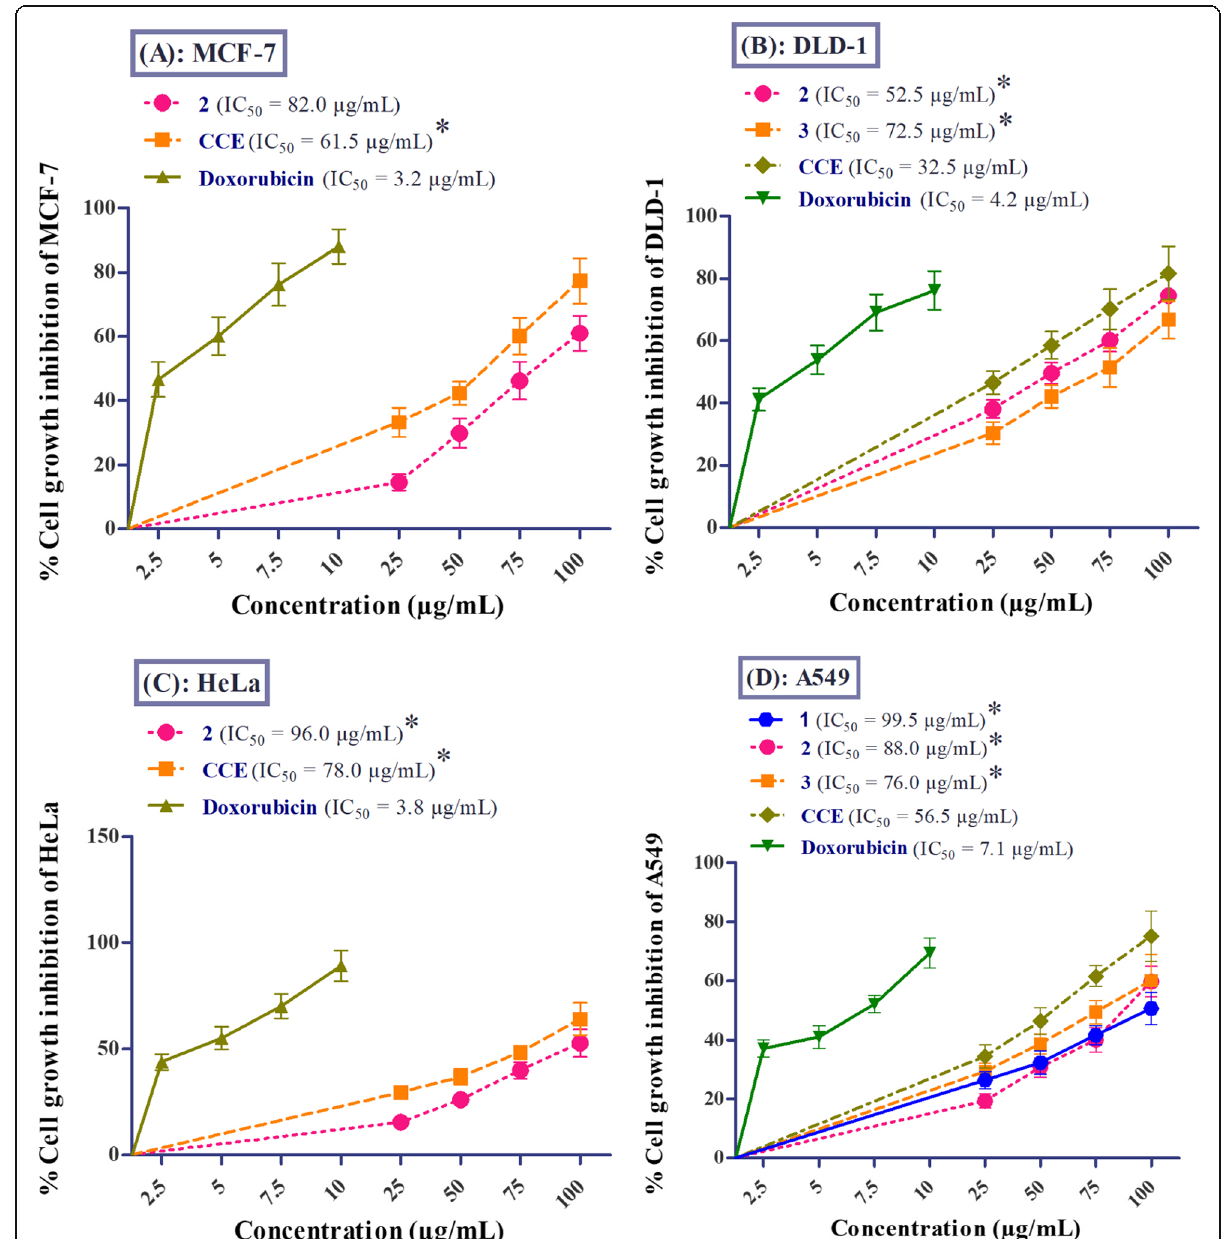
Fig. 4. Percentage growth inhibition and IC 50 values of isolated metabolites and methanolic extract of Cardiospermum canescens ( CCE ) against MCF - 7 , DLD - 1 , HeLa , and A549. MCF-7, breast cancer cell line; DLD-1, colon cancer cell line; HeLa, cervical cancer cell line; A549, lung cancer cell line; n = 3, mean ± SD values. Statistical analysis: one-way ANOVA followed by t test. *Statistically significant ( p < 0.05) between cell lines treatment with compounds and